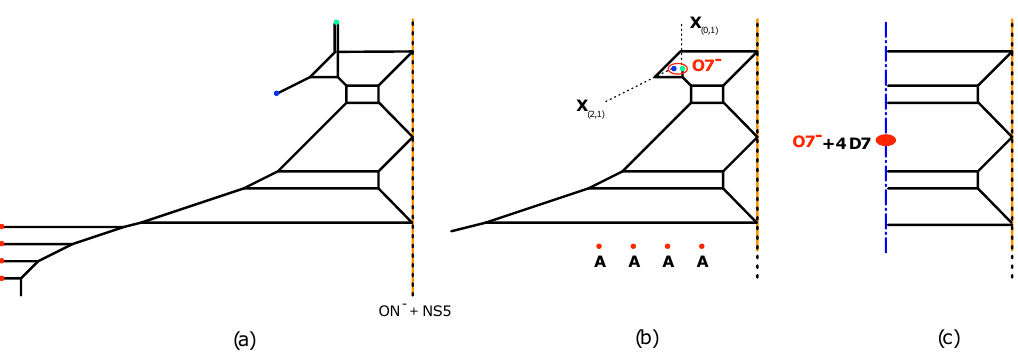
Figure 17 . (a) A 5-brane con(cid:12)guration for the SU(6) 0 +1 TAS +1 AS +4 F theory. (b) Its 7-brane con(cid:12)guration where 7-branes with charges (2 ; (cid:0) 1) and (0 ; 1) can be converted into an O7 (cid:0) -plane. (c) A 5-brane con(cid:12)guration for the SU(6) 0 + 1 TAS + 1 AS + 4 F theory with two orientifold planes. SU(6) + 1TAS + 1AS + 0